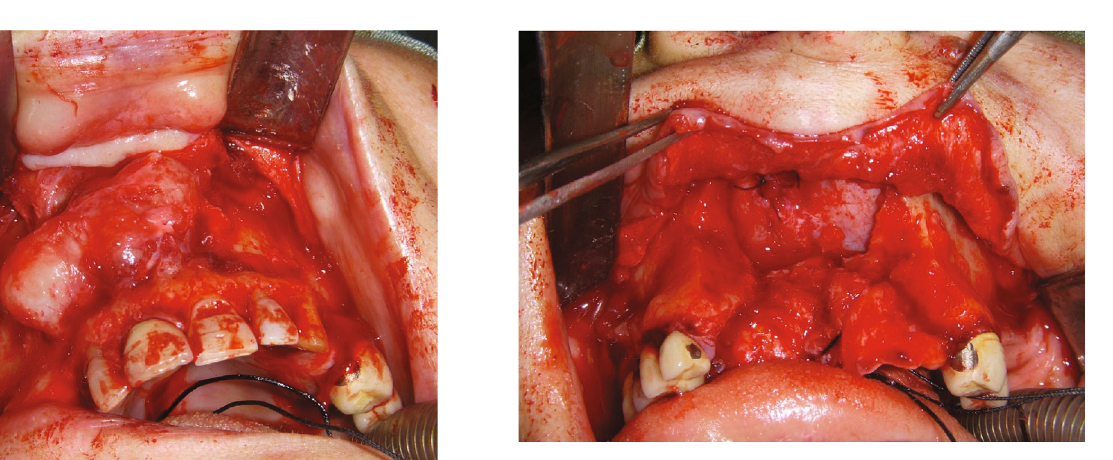
Figure 5: Surgical defect after resection of the neoplasm, involving the anterior nasal fl